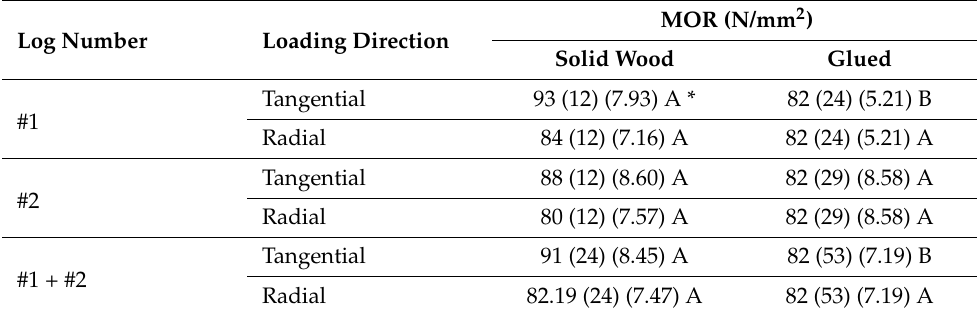
Table 6. Summary of mean values of modulus of rupture in bending (MOR).